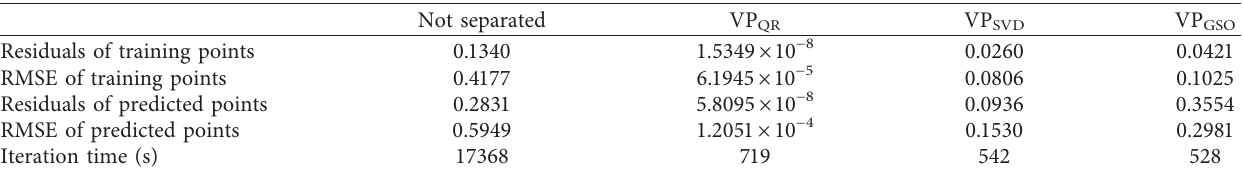
Figure 2: Curves of training and prediction points: (a) not separated, (b) QR, (c) GSO, and (d) SVD. Table 1: Quantitative